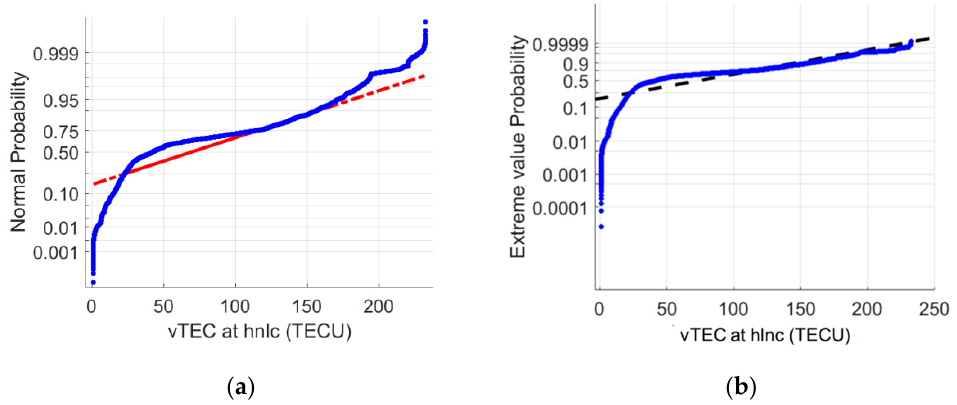
Figure 3. Probability distribution tests of TEC against the Normal (panel a ) and the Extreme Value (panel b ) distributions. The TEC data are from the LHUE station from 30 October 2003. Red and black broken lines represent normal and extreme value distribution, respectively.